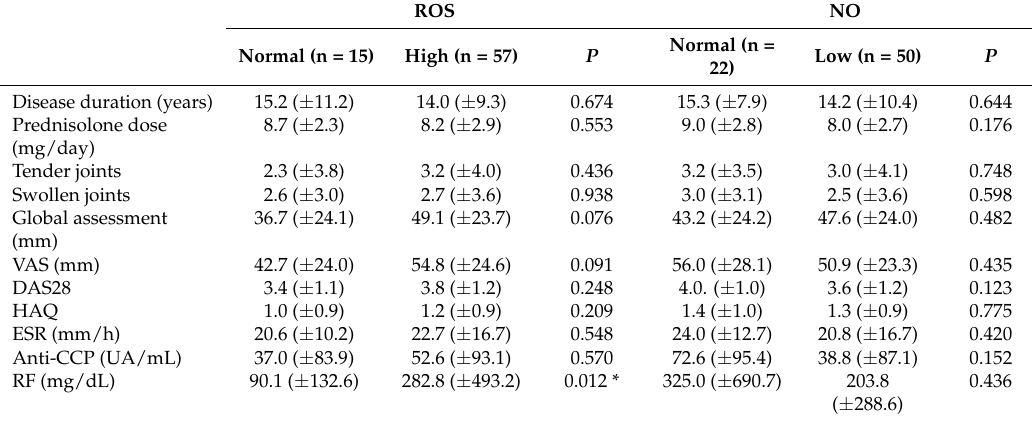
Table 3. Disease characteristics in RA patients according to ROS production and NO